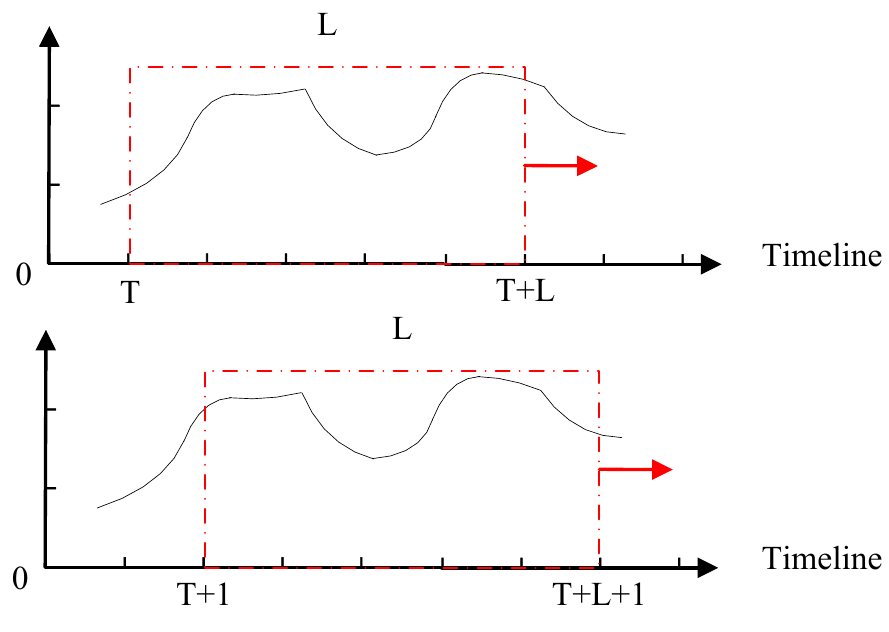
Figure 7. Schematic diagram of a scrolling time window.